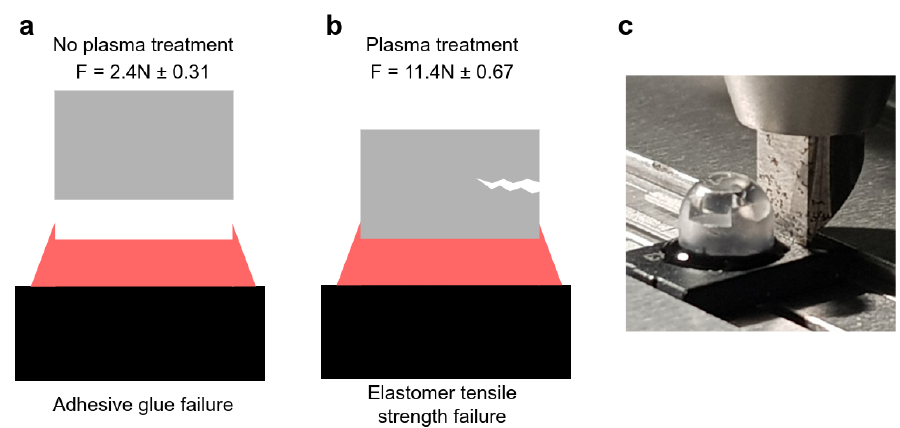
Figure 3. Shear strength testing of the elastomer with the embedded magnet. ( a ) When the glue is applied without plasma treatment, adhesive glue failure occurs. ( b ) Plasma treatment improves the resistance 5-fold, and the failure lies in the elastomer instead. ( c ) Picture of the testing